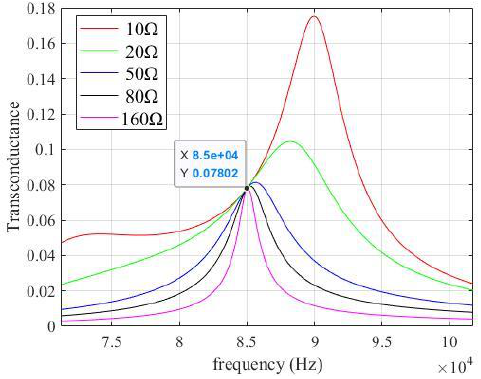
Figure 9. Transconductance with respect to frequency for different load conditions.